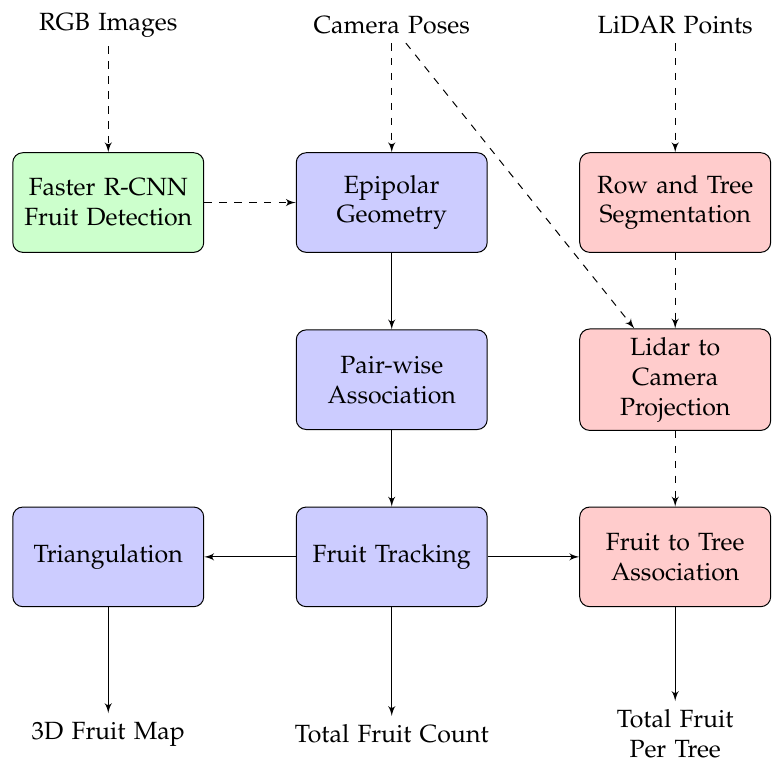
Figure 1. Flow chart of the proposed algorithmic pipeline. Fruit is detected within each RGB image using Faster R-CNN. This is the only step that uses the image data (shown in green). Using the camera poses provided by the navigation system, the the fruit is associated and tracked through sequences of multiple images from multiple viewpoints and triangulated to locate in 3D, using a sequence of geometric operations (blue). Lidar data (red) are used to associate the fruit to the corresponding tree.